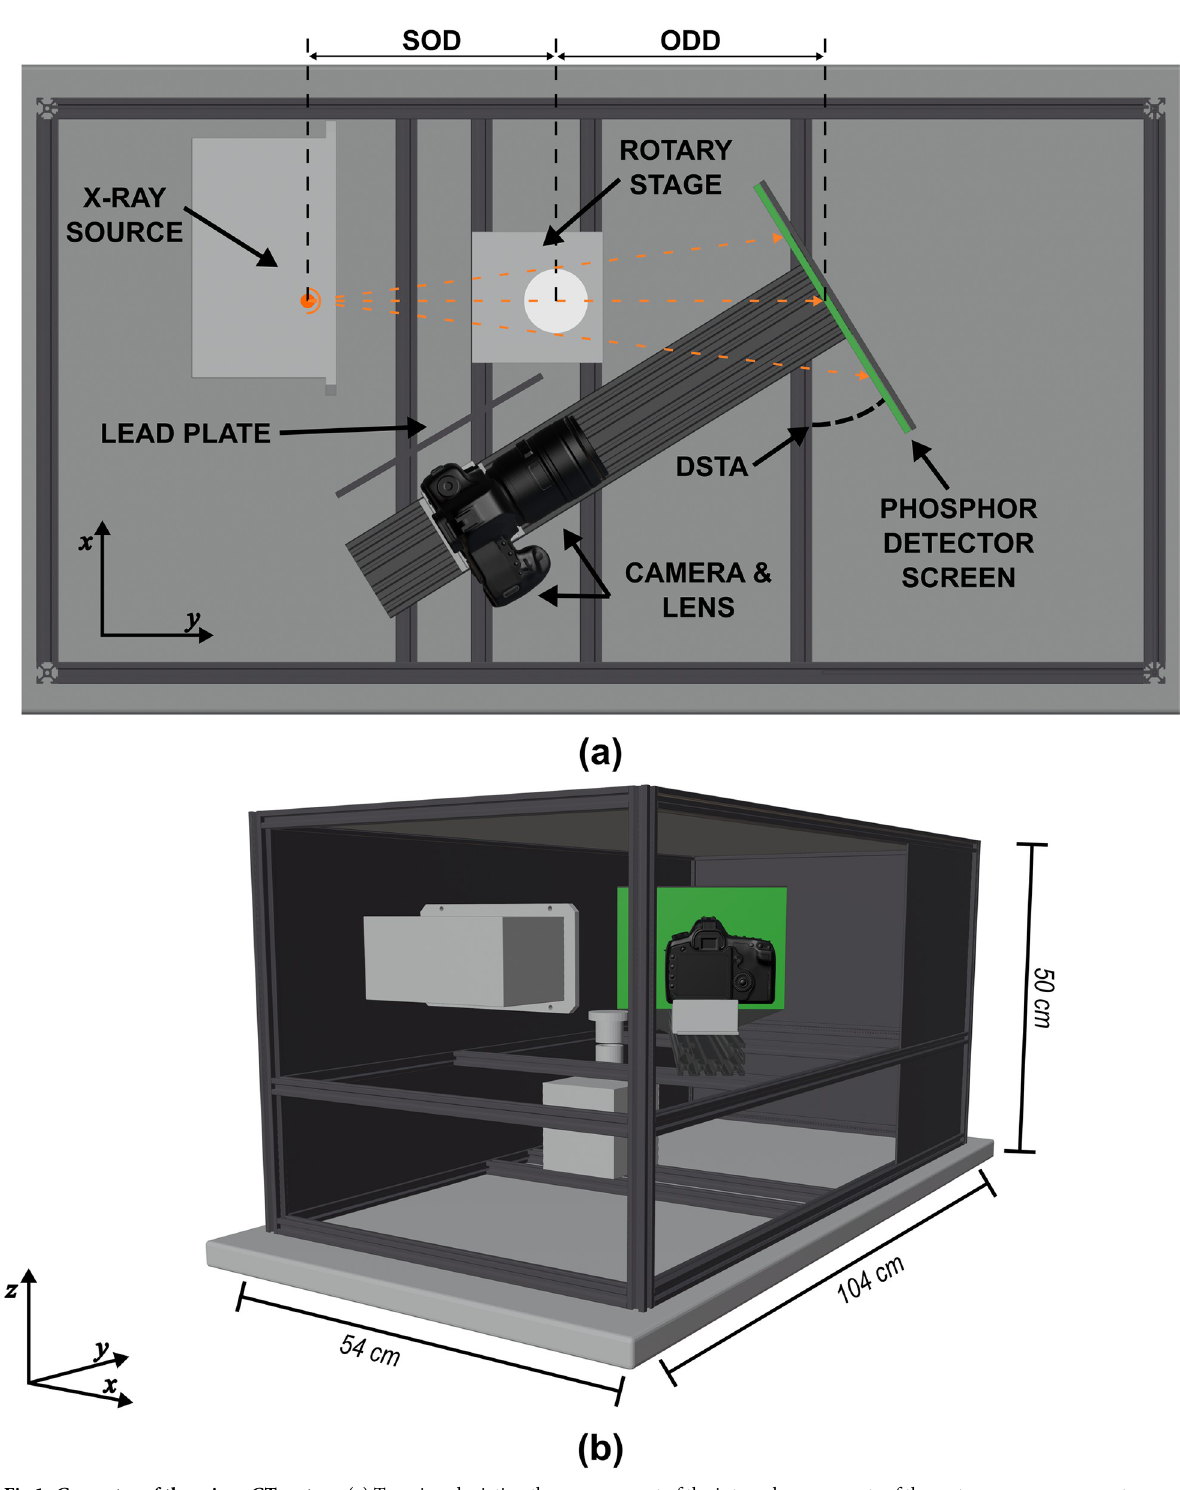
Fig 1. Geometry of the micro-CT system. (a) Top view depicting the arrangement of the internal components of the system: x-ray source, rotary stage, phosphor detector screen, detector-screen tilt angle (DSTA), lead plate, camera, lens, source-to-object distance (SOD), and object-to-detector distance (ODD). The orange dotted-lines represent the trajectory of the polychromatic, cone-shaped, x-ray beam. (b) Perspective view of the system showing the arrangement of the various 20 x 20 mm aluminum extrusion profiles. One of the opaque panels was removed from the 3D rendering to allow visualization of the internal